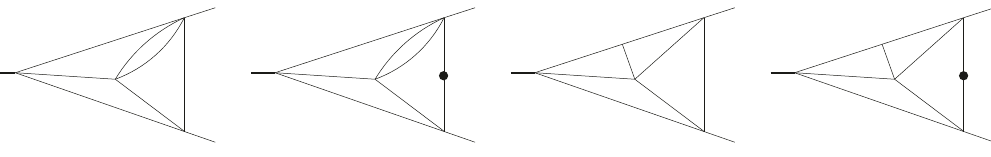
Figure 2 . The planar masters from irreducible multi-component